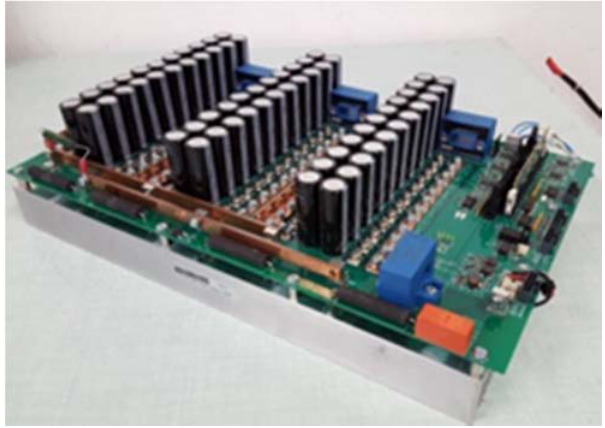
Figure 9. View of the power electronic controller.